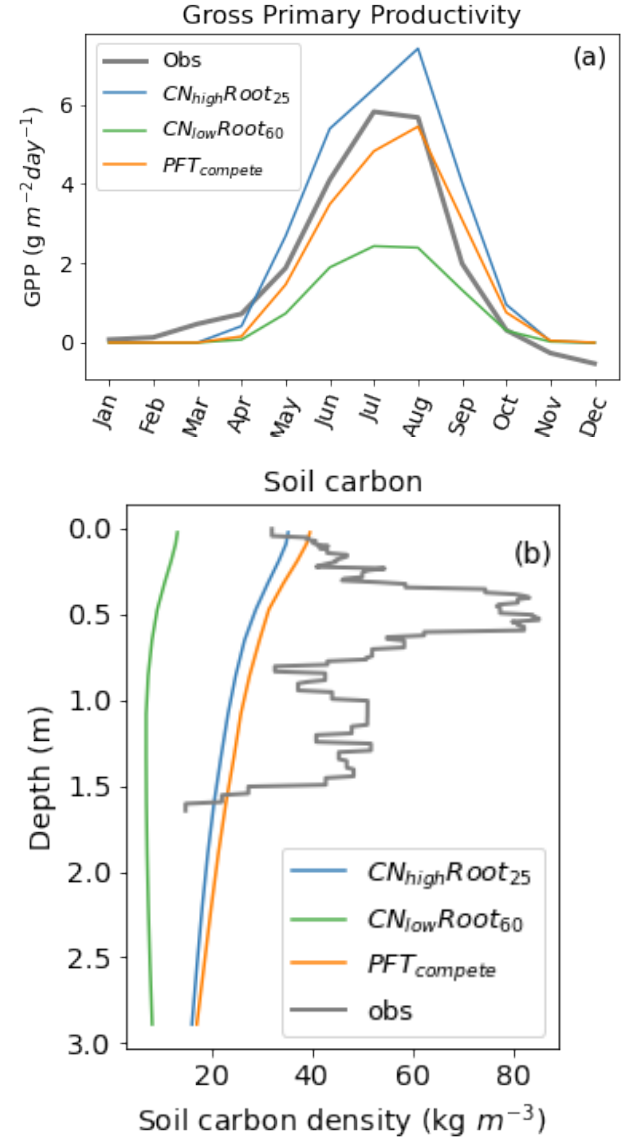
Figure 2. ( a ) Seasonal cycle of gross primary productivity (GPP) and ( b ) the profile of soil car- bon simulated by the Control simulation for three configurations: CN high Root 25 , CN low Root 60 , and PFT compete